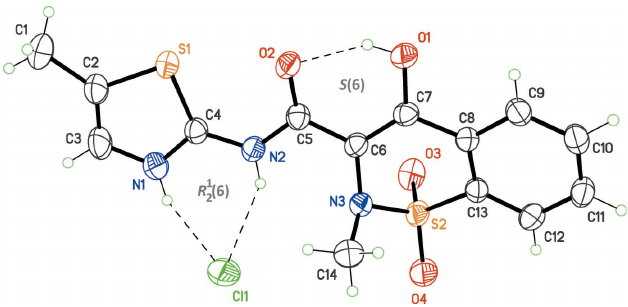
Figure 1 Molecular structure of the title compound, with displacement ellipsoids at the 50% probability level for non-H atoms. Dashed lines represent intramolecular hydrogen bonds (Table 1, entries 1–3). The labelling scheme is that adopted for MX (cid:2) HBr (Tumanov et al. ,